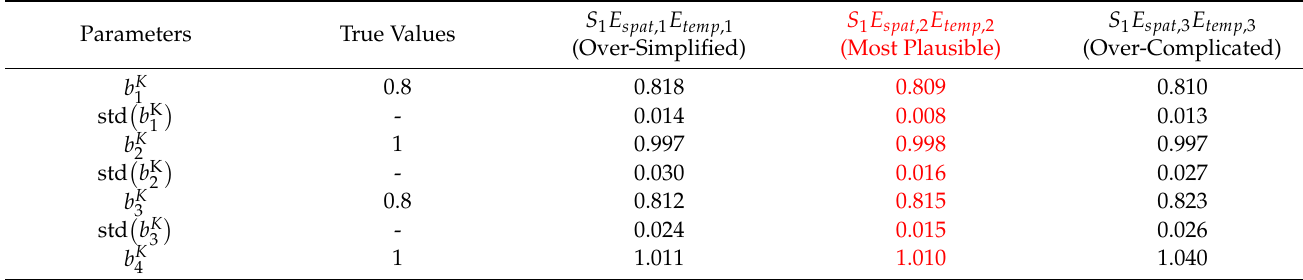
Table 5. Parameter identification results (damaged case).